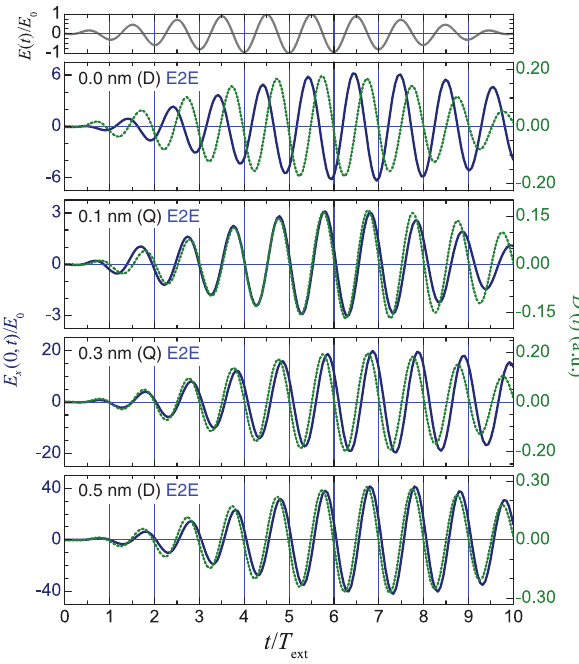
Figure 10: Time evolution of total electric fields (solid blue lines) at the middle of the dimer junction ( r = 0) and induced dipoles (dashed green lines) due to the resonant coupling of selected modes of the E2E nanoparticle dimer with an applied external monochromatic field (depicted in the upper panel) of frequency ω = 10 -6 a.u. amplitude E 0